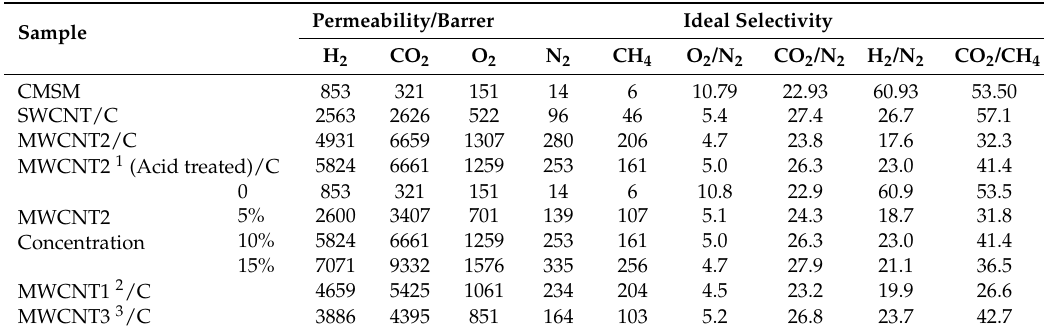
Table 10. Gas permeability and selectivity of pure CMS membrane and C/CNT hybrid membranes [89]. Sample